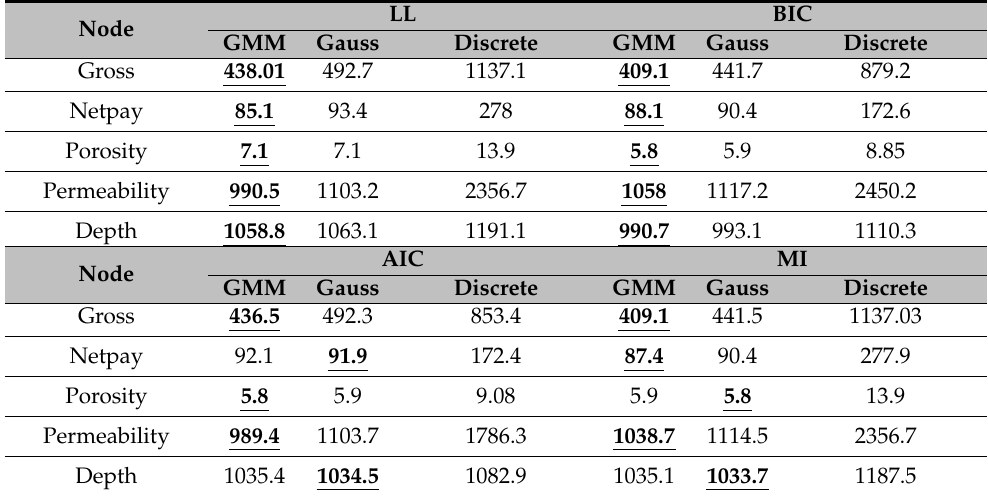
Table 1. RMSE of restoration for continuous nodes with different methods of structural learning (BIC, AIC, LL, MI) and parameter learning methods for oil and gas parameters.